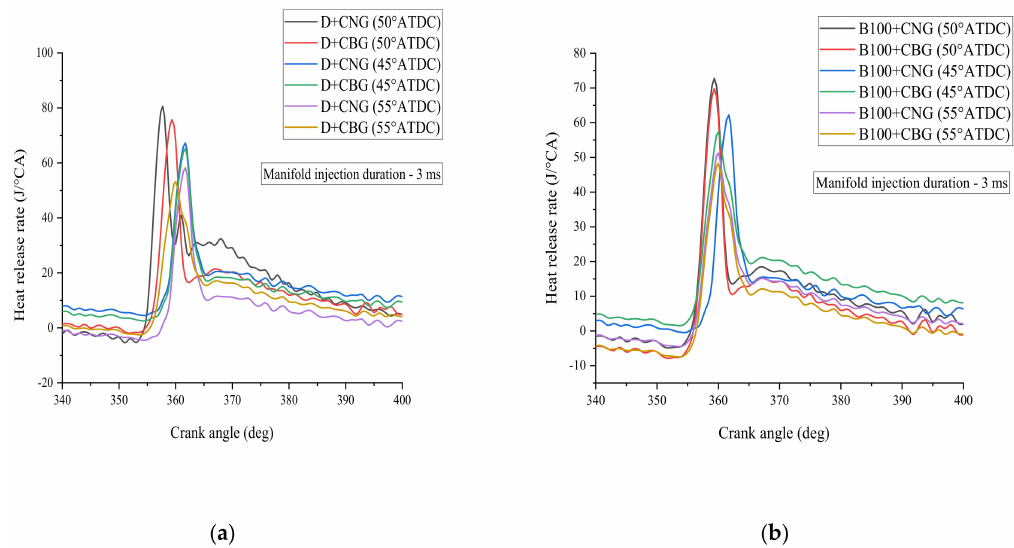
Figure 8. Variation of HRR with crank angle (CA) at different ITs. ( a ). Variation of HRR with CA for diesel as DIF. ( b ). Variation of HRR with CA for B100 as